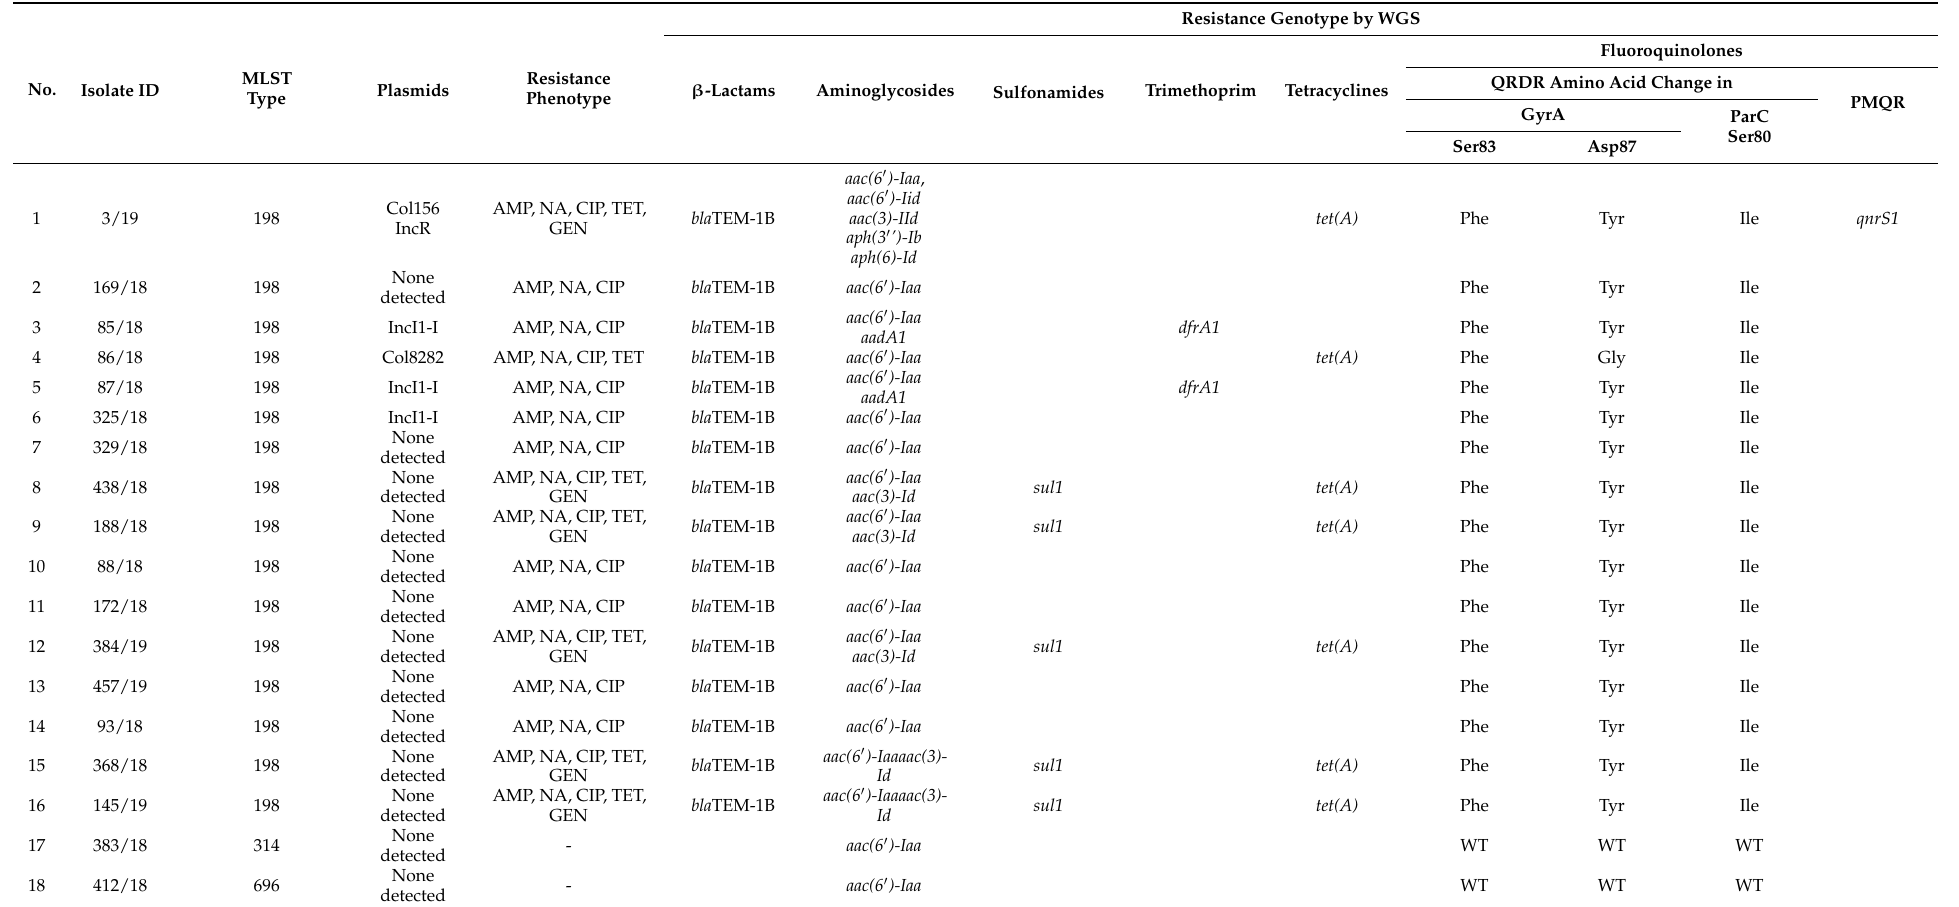
Table 2. The results of phenotypic and genotypic antimicrobial resistance profile, MLST type and plasmid profile of 18 tested S. Kentucky isolates from humans.